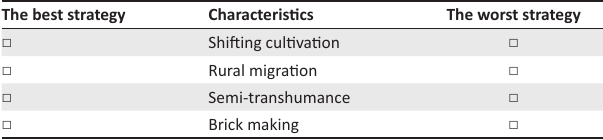
TABLE 1: A sample of the best and worst scaling